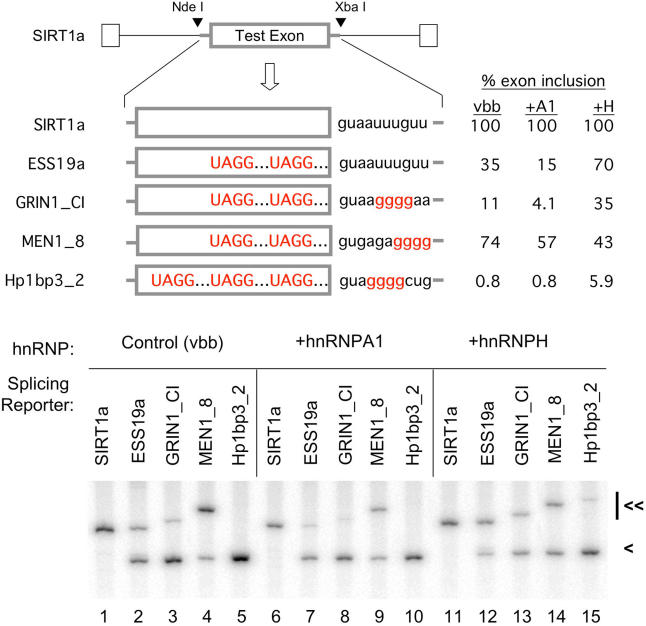
Exons Identified by Bioinformatics to Contain UAGG and
GGGG Motif Patterns: Analysis of Splicing Patterns in a Heterologous Context and Effects of hnRNP Co-Expression
Exons were cloned from mouse genomic DNA with 12 nucleotides of flanking intron sequence on each side. Each fragment was inserted into the SIRT1a context between the NdeI and XbaI restriction sites (Test Exon). SIRT1a is identical to SIRT1 except for the NdeI and XbaI sites located 12 nucleotides upstream and downstream of the middle exon, respectively. The segment between the NdeI and XbaI restriction sites represents the region of SIRT1a replaced by test exons. ESS19a is the same as ESS19 except for the presence of the indicated restriction sites. Test exons included the CI cassette exon of rat GRIN1 (GRIN1_CI), exon 8 of MEN1 (MEN1_8), and exon 2 of Hp1bp3 (Hp1bp3_2). Splicing reporters were expressed in C2C12 cells in the presence of vector backbone (vbb), or with hnRNPA1 or hnRNPH protein expression vector at a ratio of 1:4. Exon-included (double arrowheads) and exon-skipped (single arrowheads) mRNA products were quantified from the gel shown, and used to calculate the percent exon included values (top right).